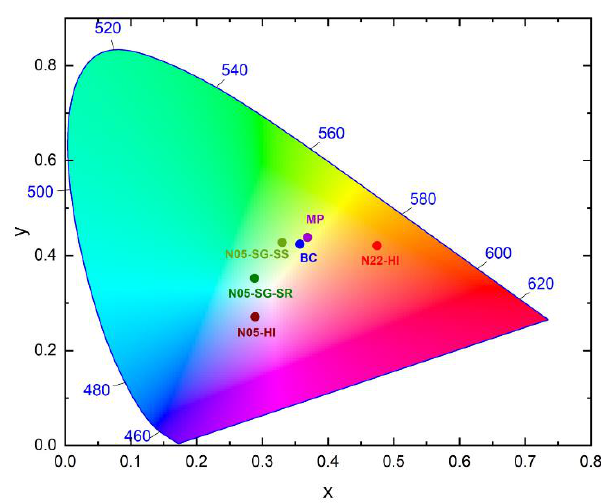
Figure 7. Color output of all ZnO samples: CIE1931 chromaticity diagram reporting the coordinates of RT RL emissions of N05-HI (dark red circle), N22-HI (red circle), N05-SG-SS (green circle), N05-SG-SR (dark green circle), MP (purple circle), and BC (blue circle). Authors should discuss the results and how they can be interpreted in perspective of previous studies and of the working hypotheses. The